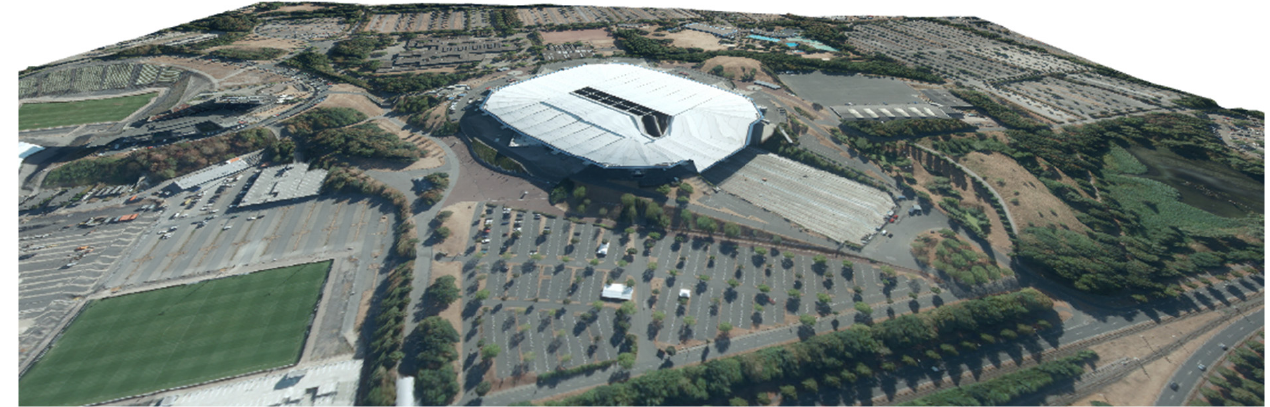
Figure 1. Static 2.5D impression of the FC Schalke 04 stadium area (own representation by Dennis Edler and Timo Wiedenlübbert).